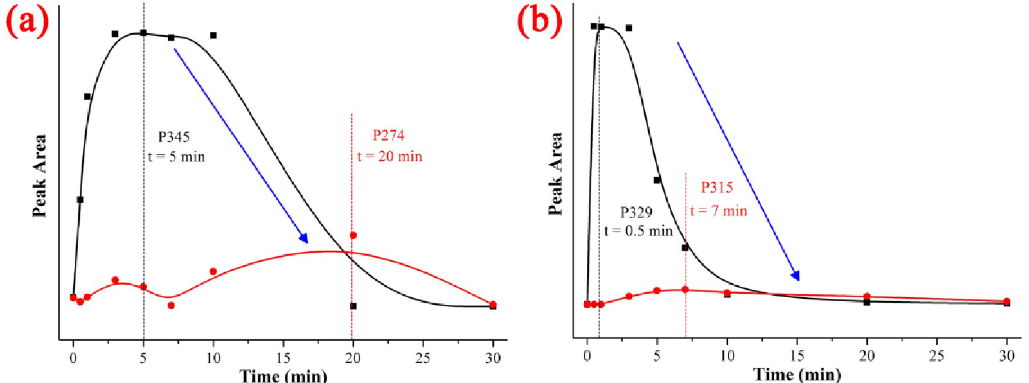
Fig 10. Chromatography of the intermediate products of NIF via UV/H 2 O 2 .